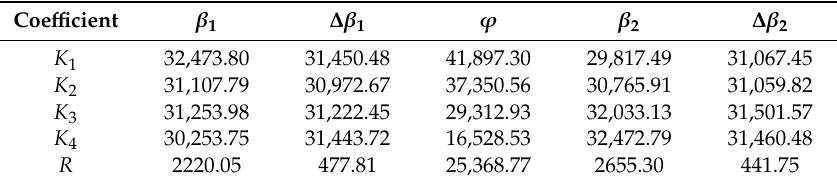
Table 7. Range analysis of pressure rise.